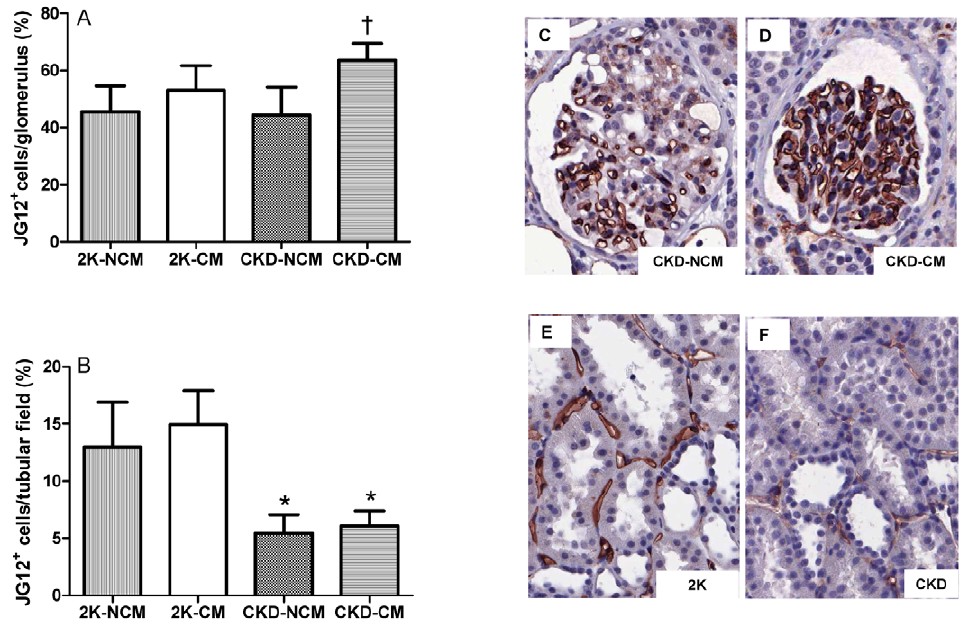
Figure 3. CM treatment increased the number of glomerular endothelial cells (A, C-D), but did not increase tubular endothelial cell number (B, E-F) shown by a JG12 staining. 2K-NCM (n=6); 2K-CM (n=6); CKD-NCM (n=13); CKD-CM (n=13). *P , 0.05: CKD vs. 2K, { P , 0.05: